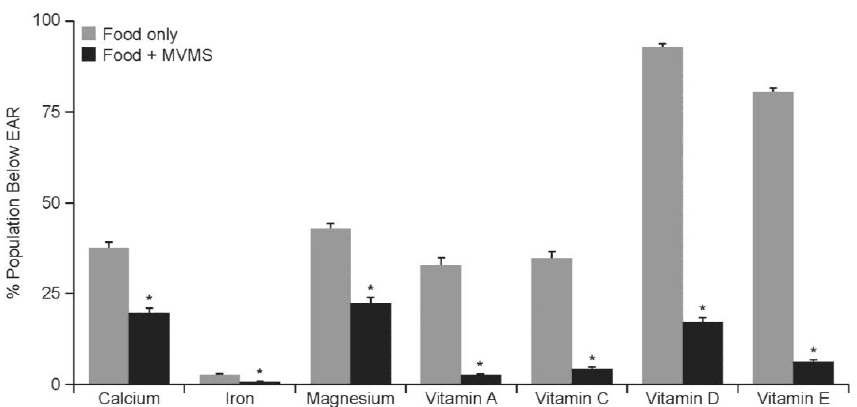
Figure 1. Proportion of subjects ≥19 years of age achieving an intake of shortfall nutrients below the EAR from food or from food + MVMS. Reprinted from Blumberg, J.B., et al. [3]. Abbreviations: EAR: Estimated Average Requirement; MVMS: multivitamin/multimineral supplement. * p < 0.01 versus food only.